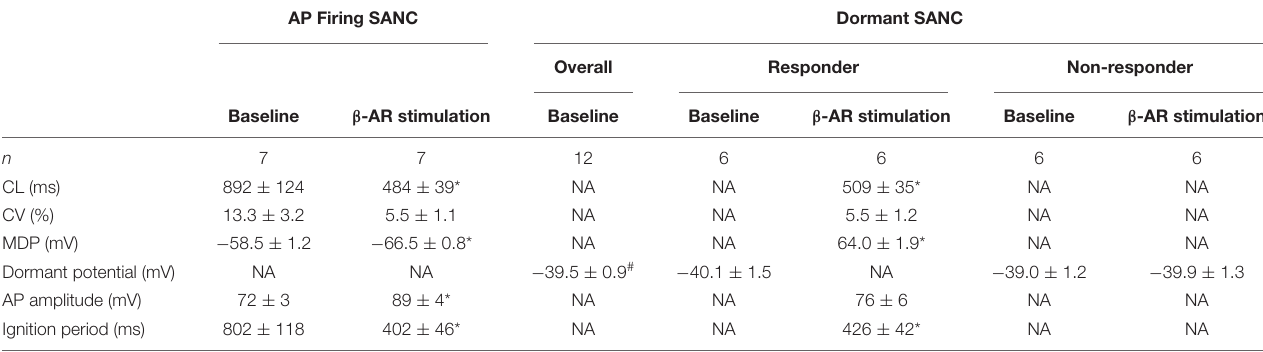
TABLE 1 | Membrane potential characteristics of initially firing/dormant guinea pig